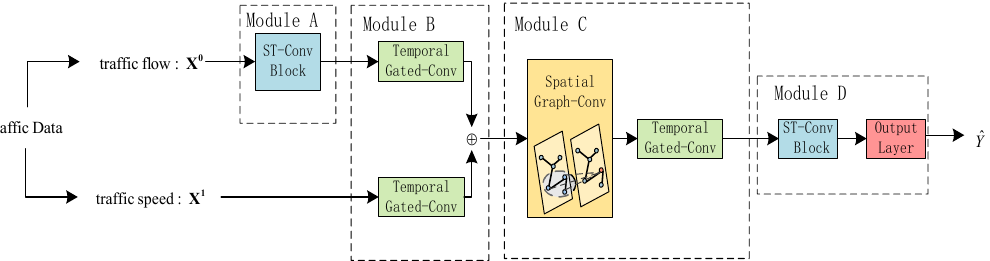
Figure 2. The framework of the FSTGCN model.